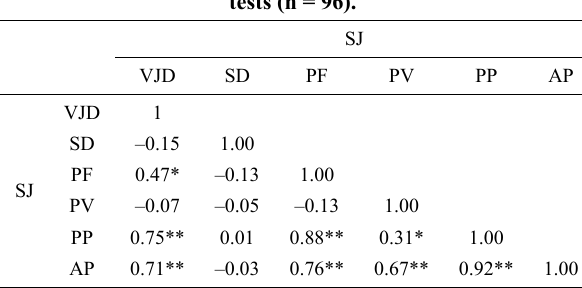
Table 5. Results of intercorrelation of variables during SJ